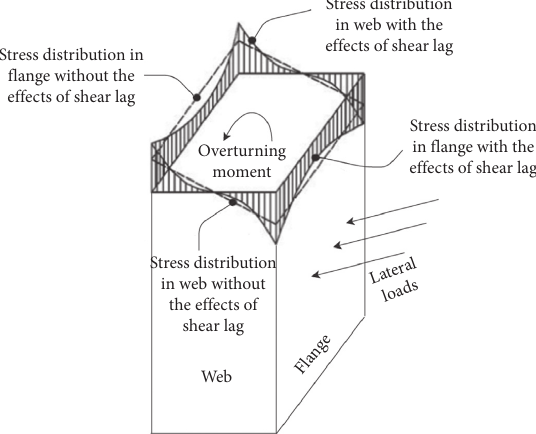
Figure 7: Stress distributions in flange and web frames of the framed tube [53].